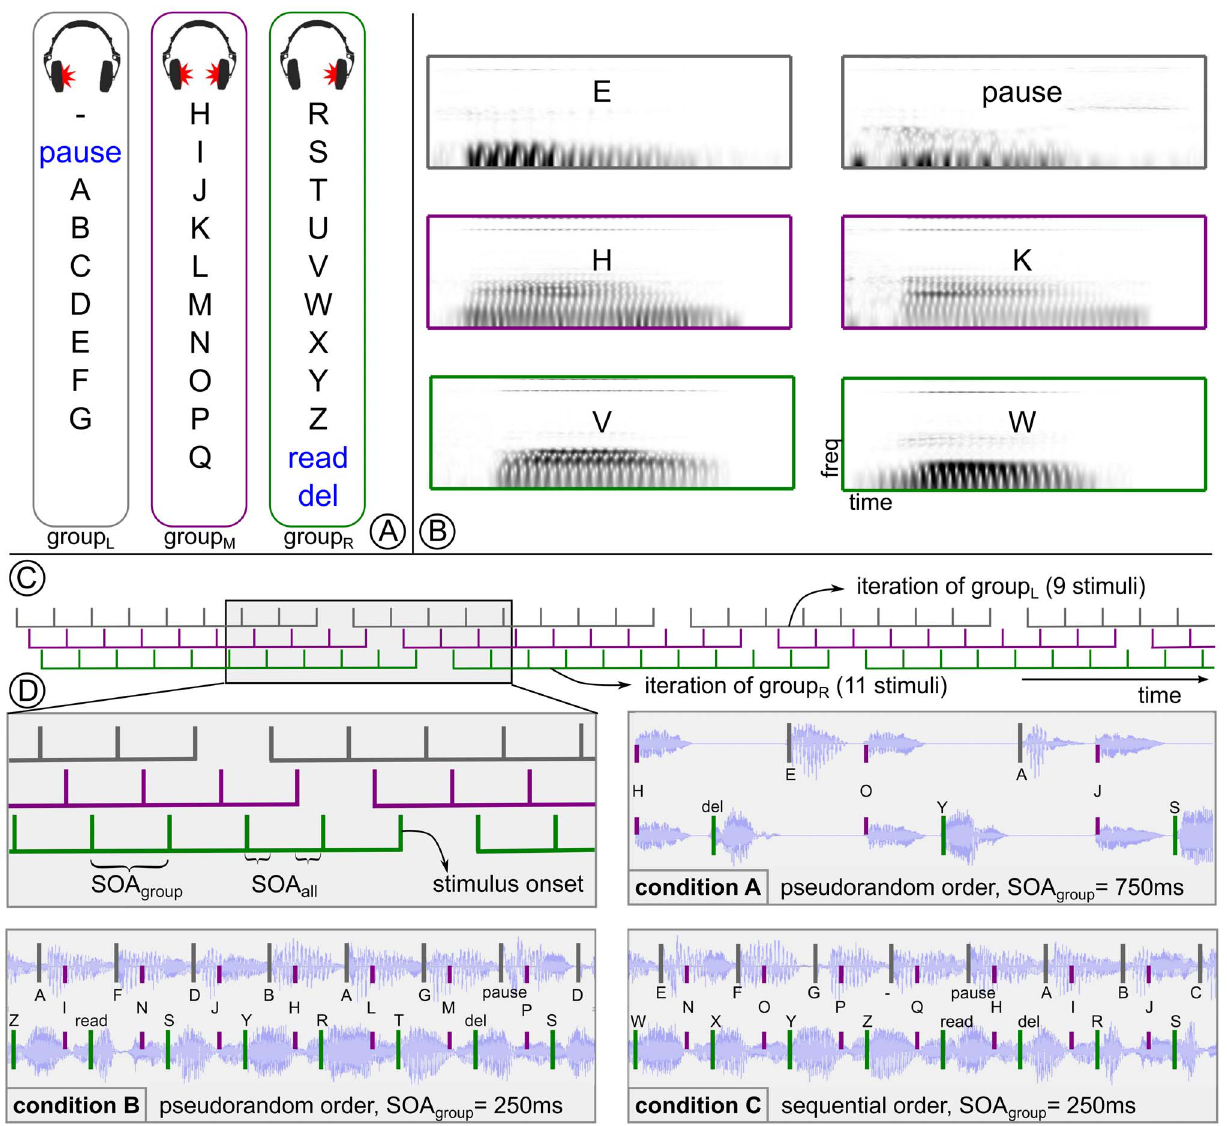
Figure 1. The alphabet consisting of 30 characters and symbols was split into 3 consecutive groups (A). Each group of letters is presented from a different direction. Spectrograms of six selected auditory stimuli are shown in B . The course of a trial is shown in C , depicting a sequence of several consecutive iterations. Part D visualizes excerpts with , 2 seconds duration. To illustrate the mapping of the three groups to the stereo headphone tracks, the corresponding waveforms for each condition are displayed in the background. Moreover, a magnification of plot C is provided in the top-left corner of D .